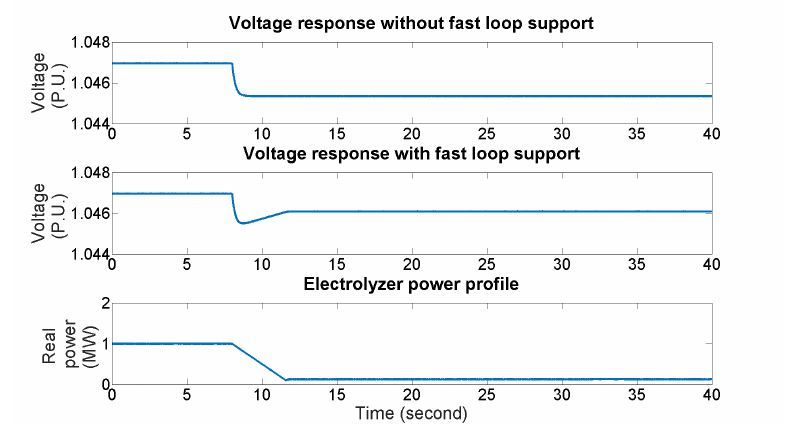
Figure 13. Case study: voltage support from small-scale hydrogen refueling station.